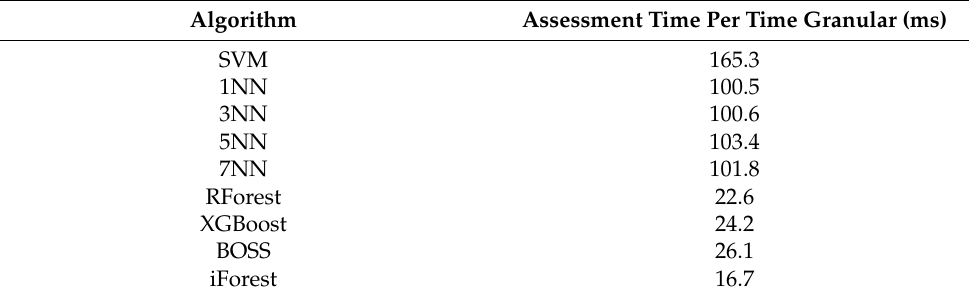
Table 6. Assessment time of our proposals in both